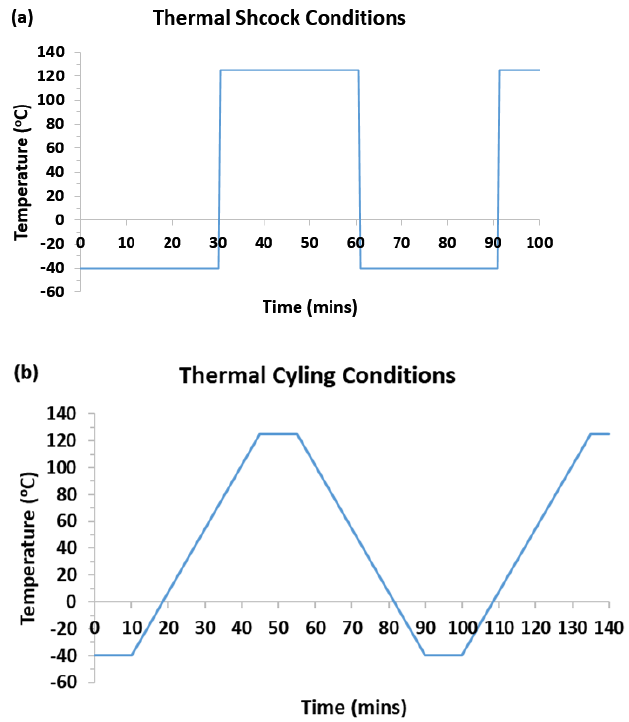
Figure 3. ( a ) Thermal shock and ( b ) thermal cycling aging conditions.